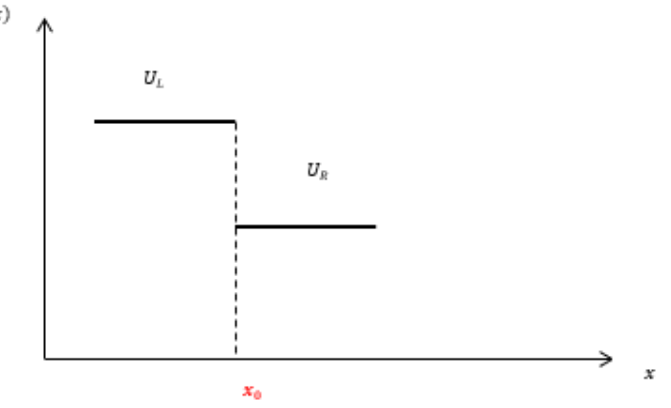
Figure 6. Initial data for the Riemann problem for the first-order solution.